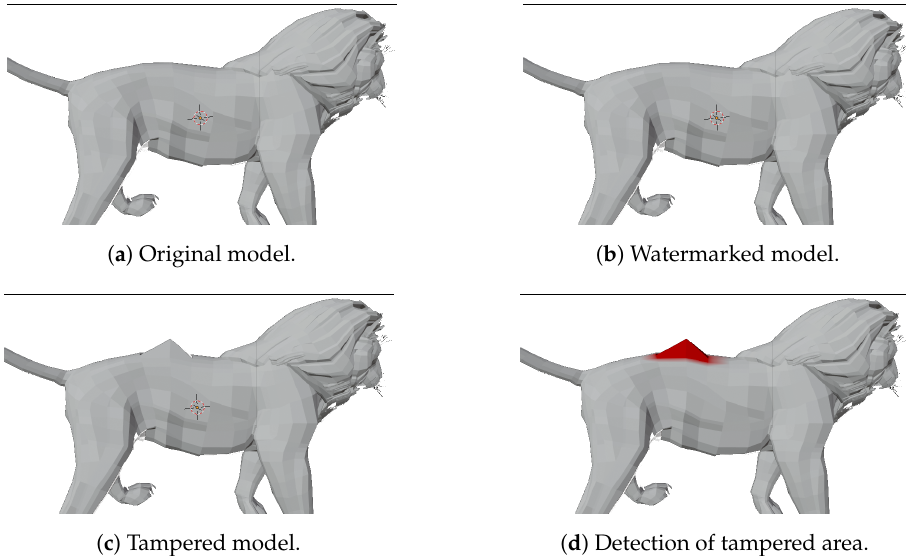
Figure 4. Application of the proposed algorithm to a model (lion).